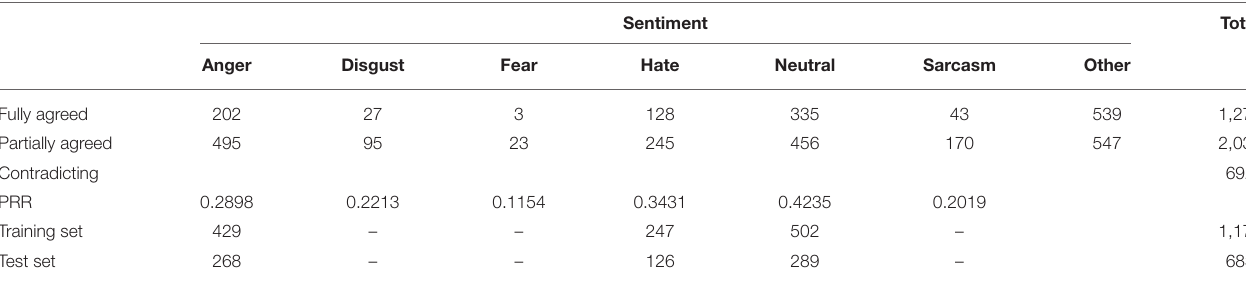
TABLE 3 | Dataset #2: